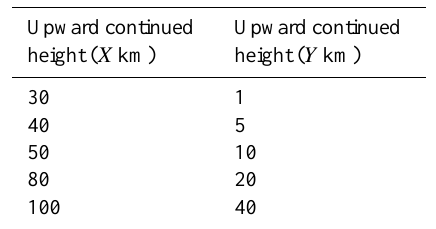
Table 1. Details of the UCR grids that were generated from the BGI Bouguer gravity data where one upward continued grid (grid( X )) (that was generated by simulating the measurement being made X km above the original surface) was subtracted from another up- ward continued grid (grid( Y )) (that was generated by simulating the measurement being made Y km above the original